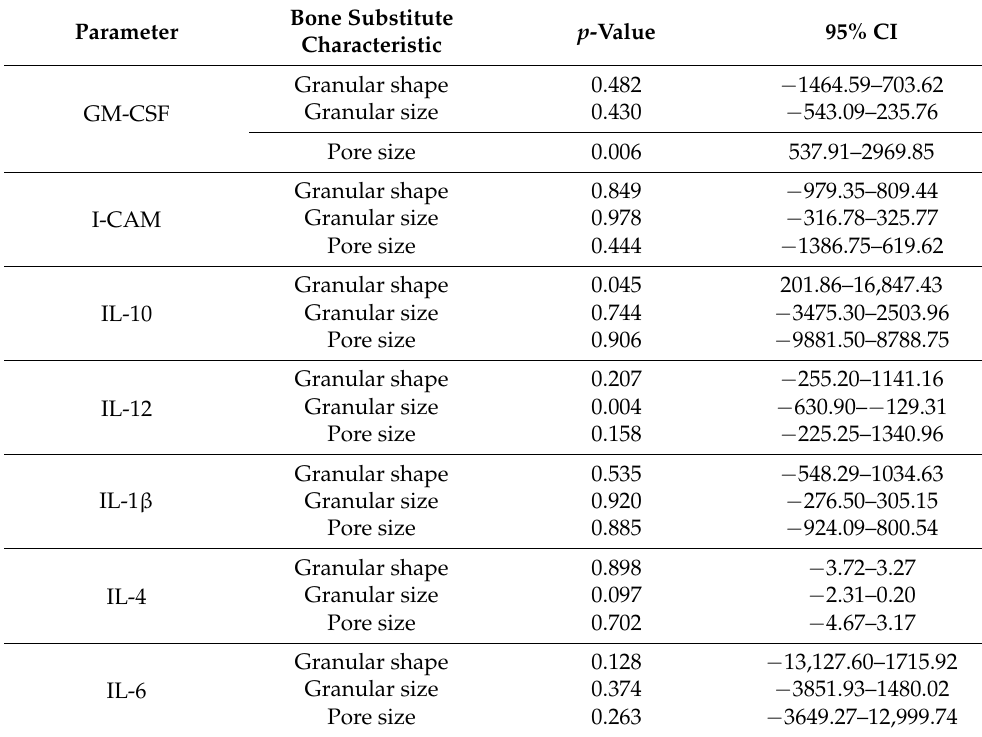
Table 3. Results of the correlation analysis using a mixed model. The table shows the significant influence of the bone substitute characteristics (granular shape, granular size and pore size) on the concentration of immunomodulatory cytokines. A p -value smaller than 0.05 is considered statistically significant. CI–confidence